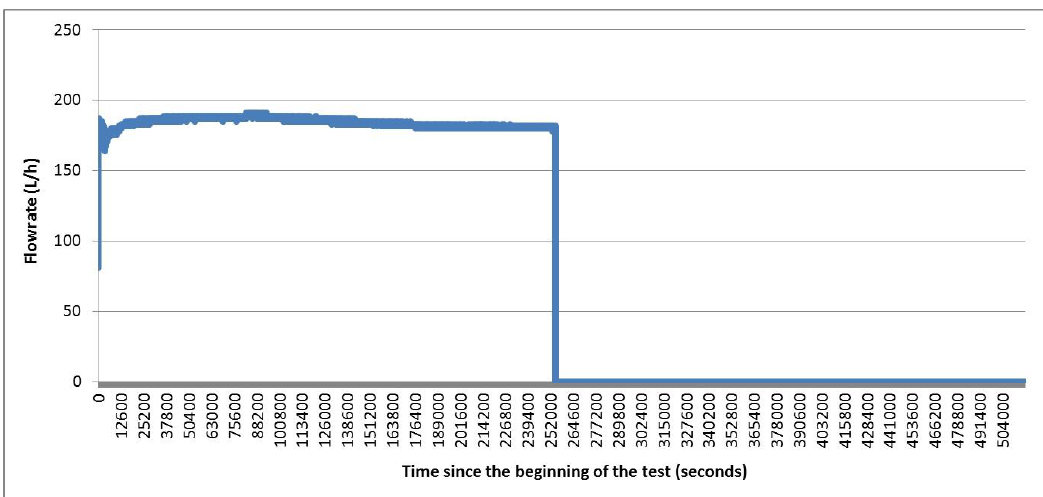
Figure 9. Flow rate during the test carried out on the experimental setup.